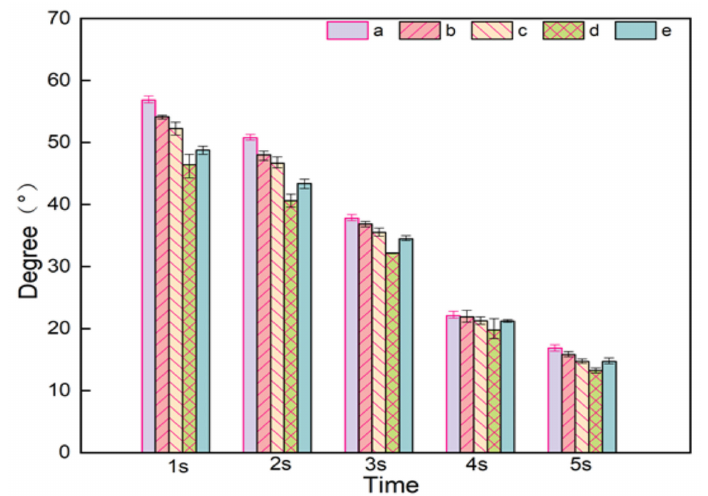
Figure 9. Contact angles of ( a ) NC0, ( b ) NC2, ( c ) NC4, ( d ) NC6 and ( e ) NC8 nanofiber membranes at different times.